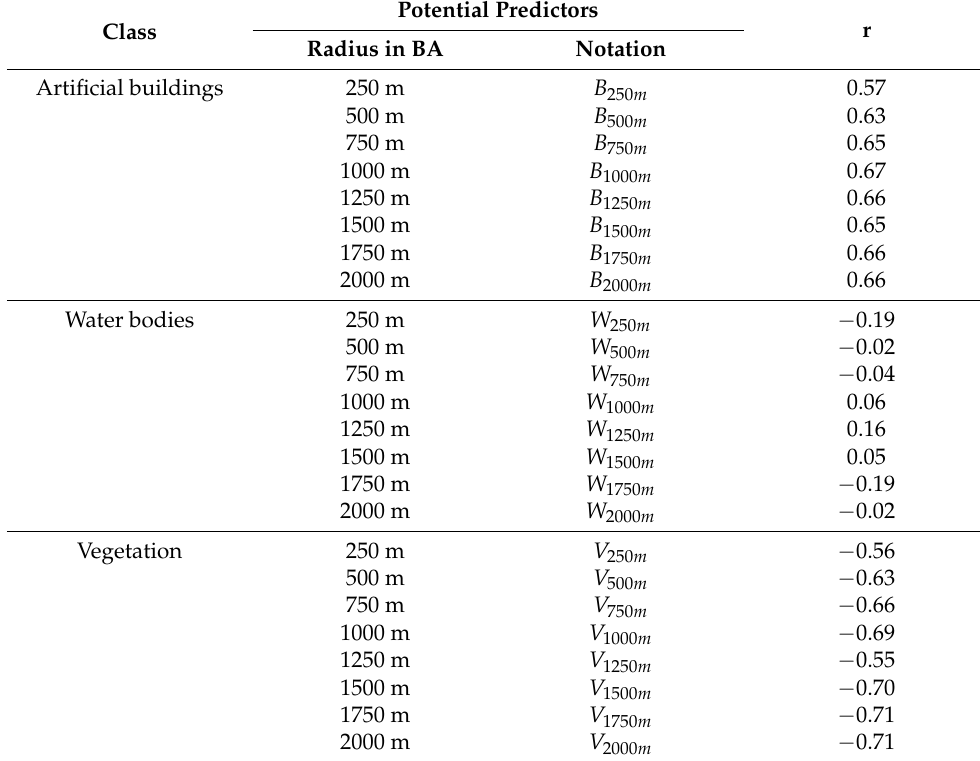
Table 3. Spearman correlation between PM 2.5 exposure and the potential predictors from the satellite image datasets. The buffering analysis is denoted as BA.